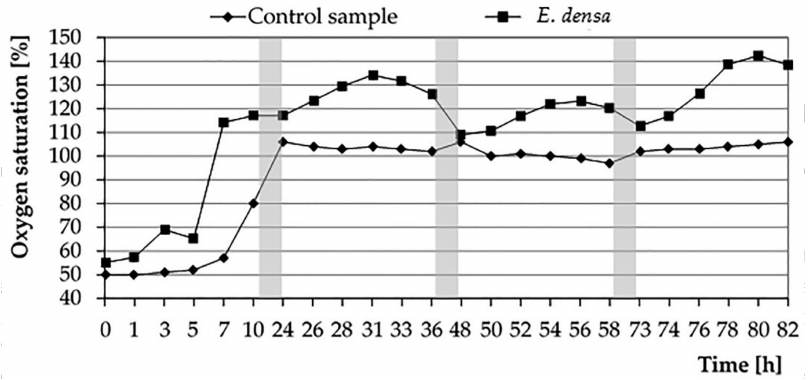
Figure 1. The changes in water oxygen saturation in a system with and without (control) E. densa in water during 4 days of the experiment (periods of nighttime—without measurement—marked as grey